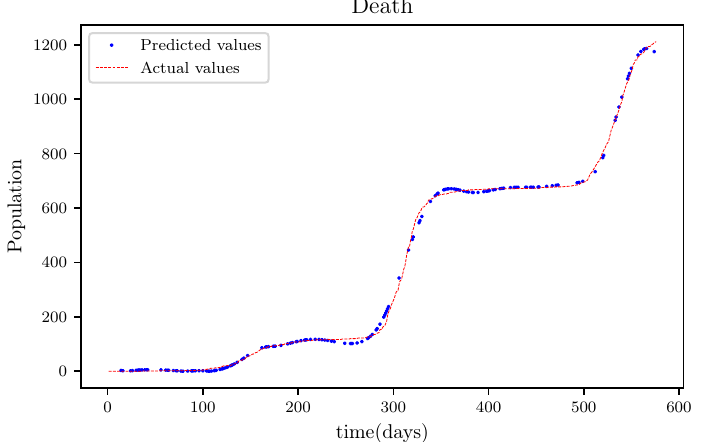
Figure 18. The graph shows a comparison of the predicted deceased population values and the actual data of the deceased population for a 530 data points.